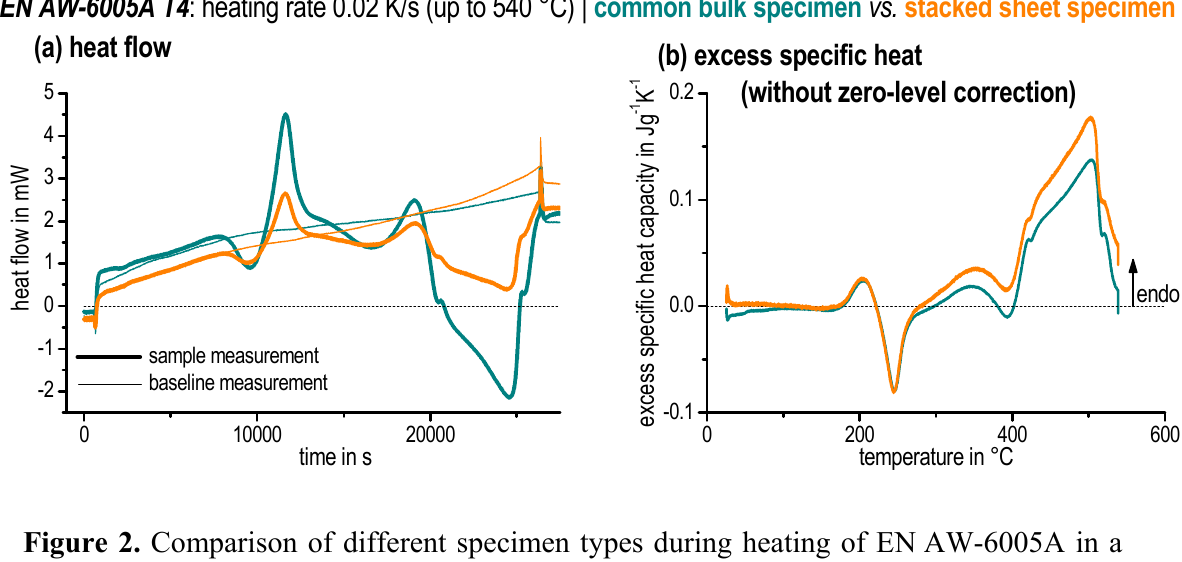
Figure 2. Comparison of different specimen types during heating of EN AW-6005A in a Setaram DSC 121: ( a ) heat-flow curves; and ( b ) excess specific heat capacity curves (normalised heating